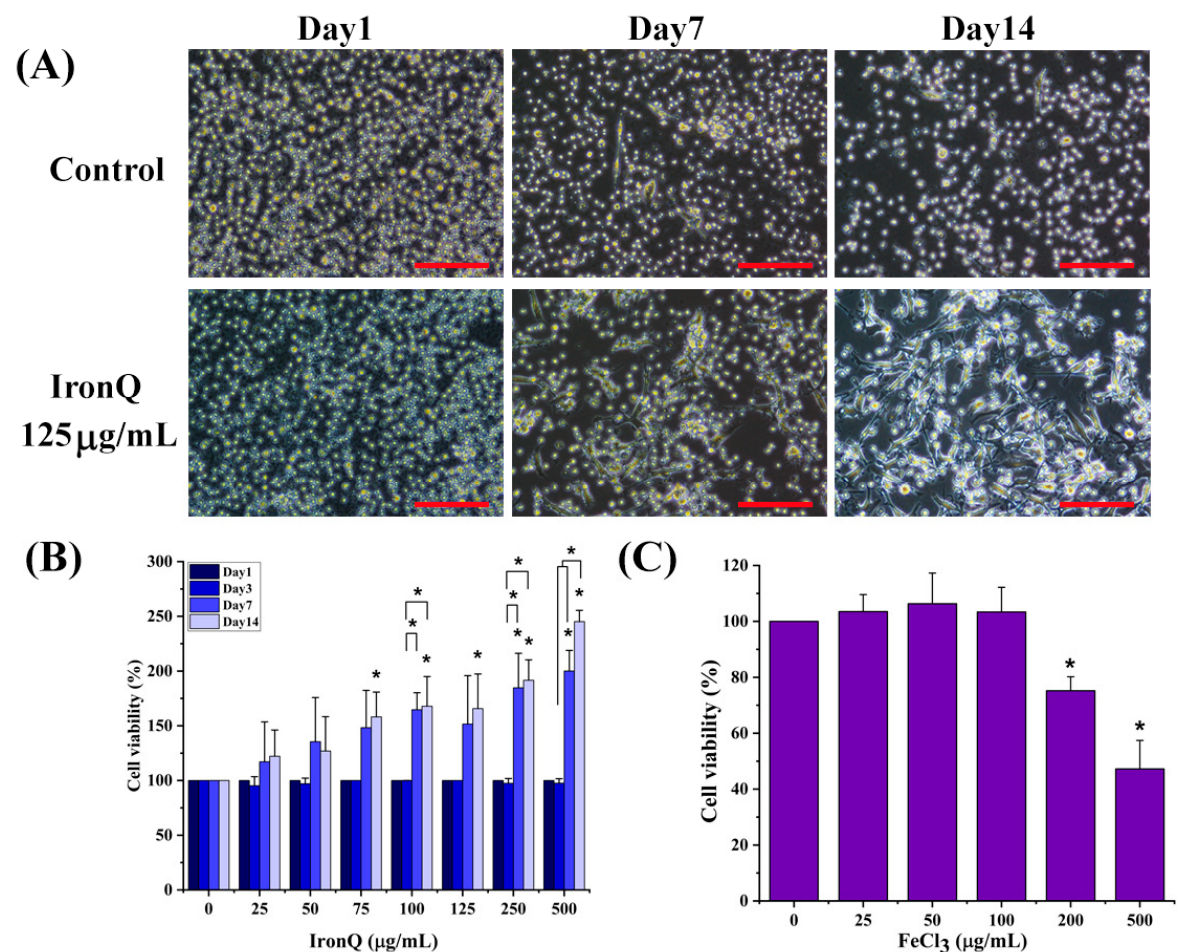
Figure 1. Cytotoxicity effects of IronQ complex in human peripheral blood mononuclear cells (PBMCs). ( A ) Phase-contrast images of the morphological states of PBMC observation at different time points on PBMCs treated with 125 µg/mL of the IronQ. Scale bar = 100 mm. ( B , C ) Cellular viability in human PBMCs evaluated by CCK-8 assay after being treated with IronQ nanoparticle and iron ions (FeCl 3 ). The data obtained are expressed as mean ± SD (n = 8). * p < 0.05, significantly different versus control.